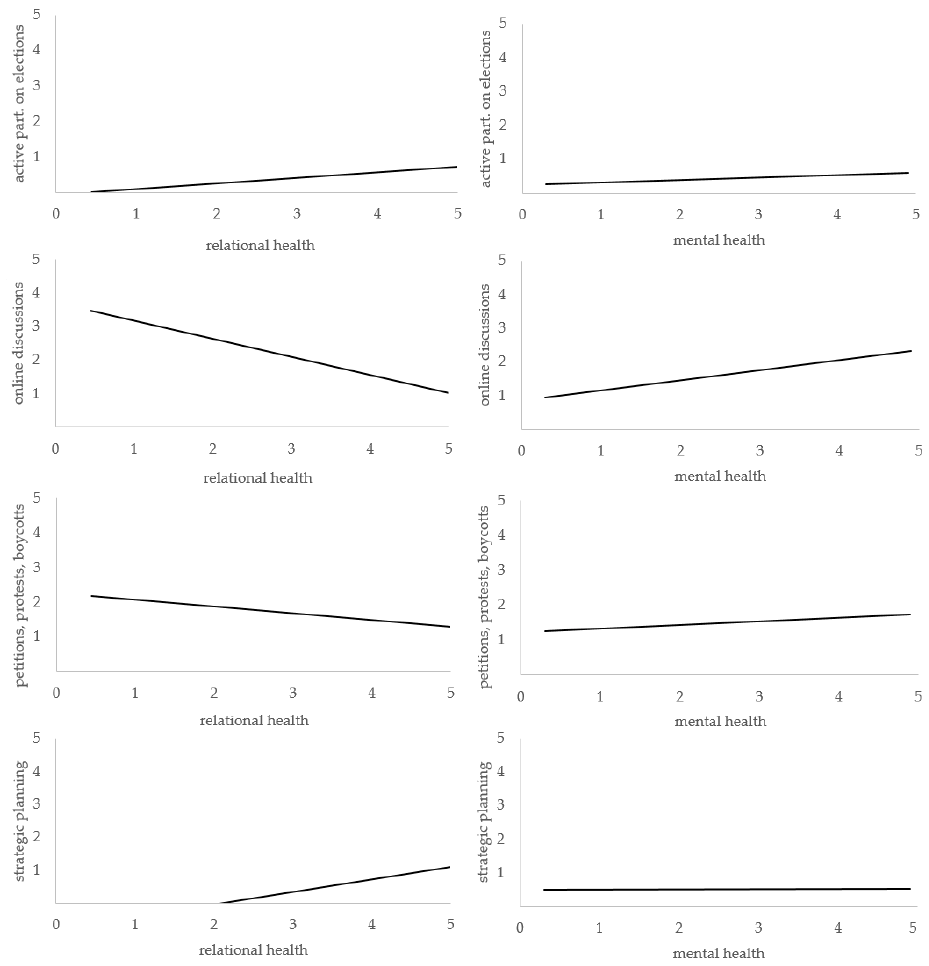
Figure 2. Prediction of linear relationships between several factors of political engagement, relational and mental health.